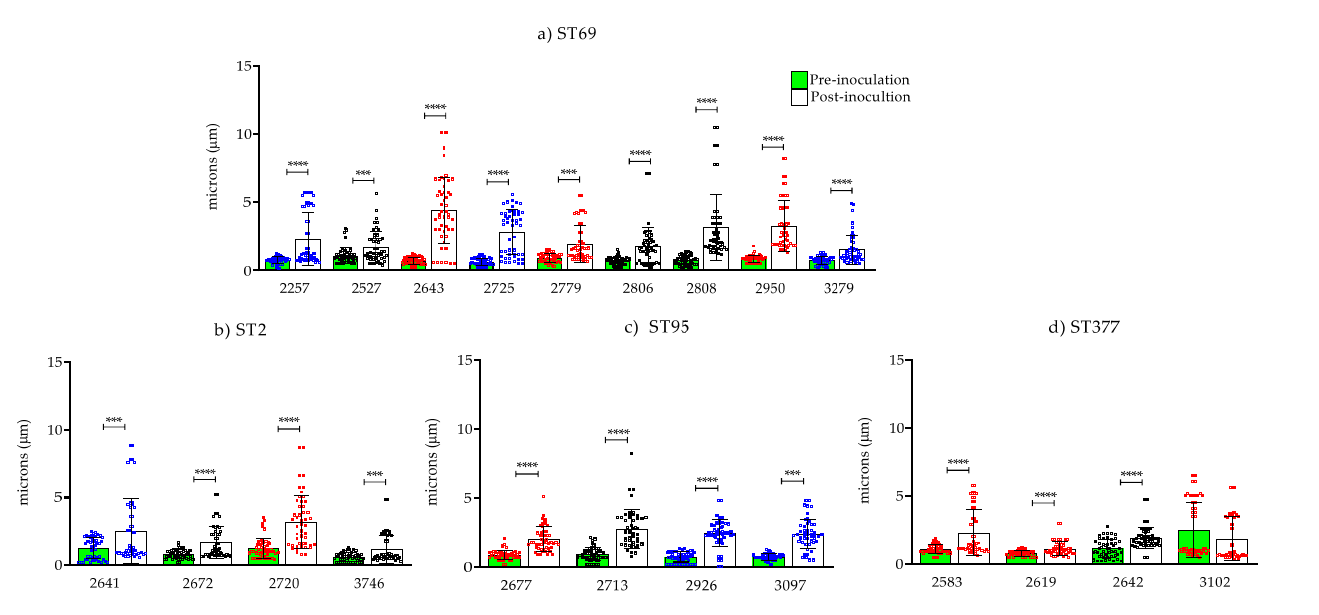
Figure 3. Capsule size pre- and post-inoculation in G. mellonella of the 21 clinical isolates of C. neo- formans var. grubii belonging to the most frequent sequence types: ( a ) ST69, ( b ) ST2, ( c ) ST95, and ( d ) ST377. Boxes are colored according to isolates’ pathogenicity: blue (low), black (intermediate) and red (high). The error bars represent the standard deviation. p < 0.001 (***); p > 0.0001 (****).